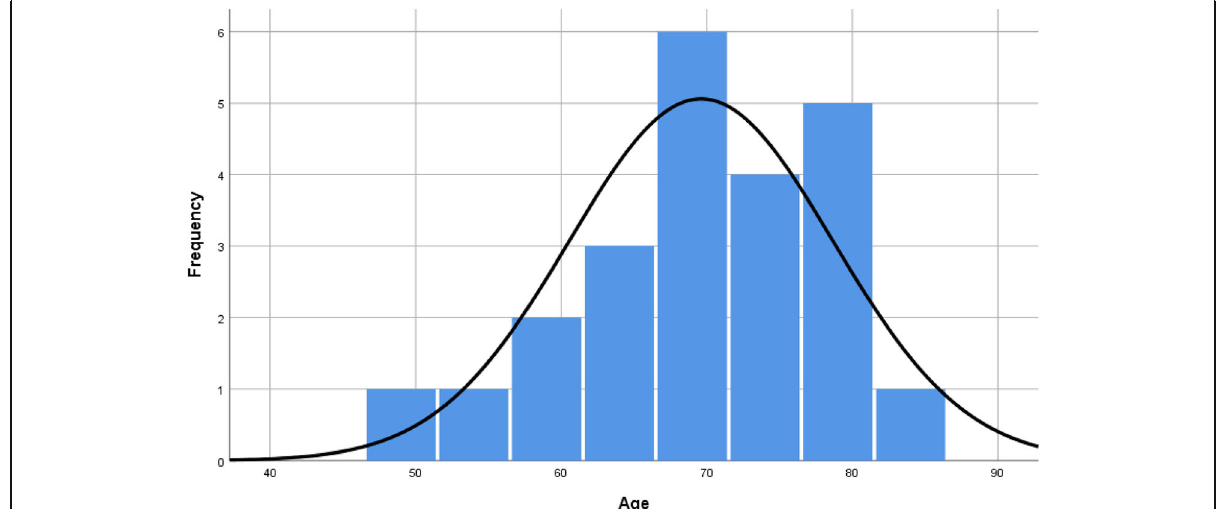
Fig. 3 Distribution of frequency by age with exemplary normal